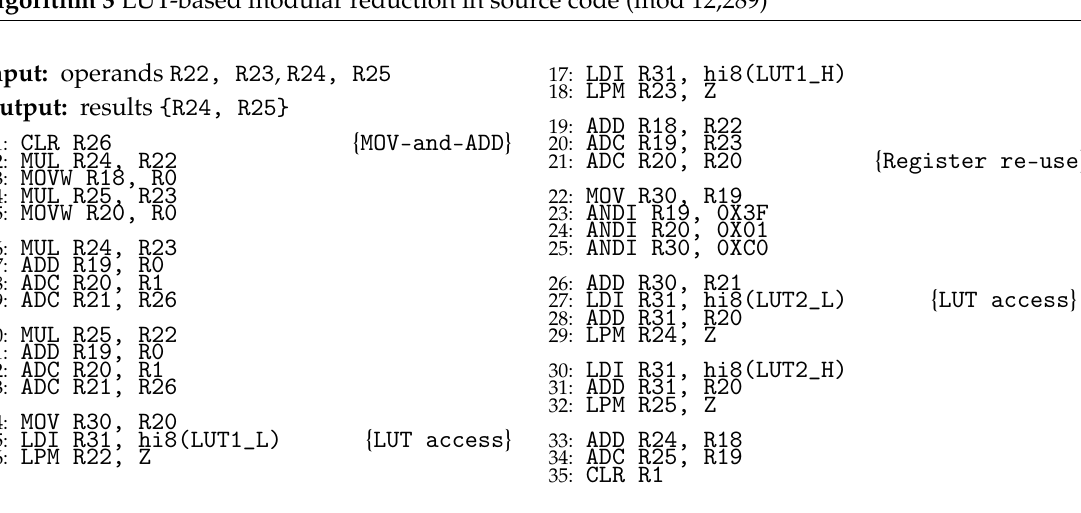
The detailed source code for LUT-based fast modular reduction is given in Algorithm 3. Algorithm 3 LUT-based modular reduction in source code (mod